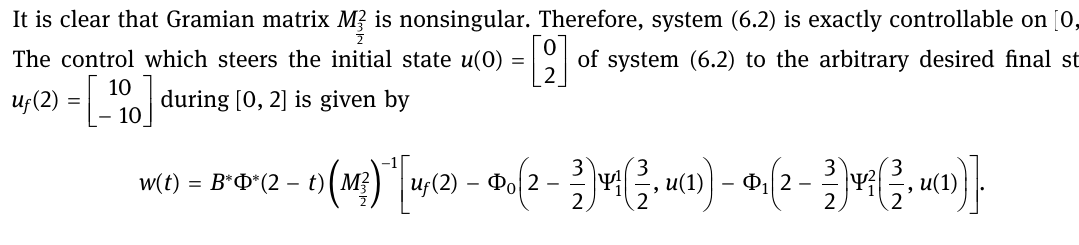
Figure 2: The trajectory of the impulsive linear system ( 6.2 ) starts from the initial state on 0, 2 [ ]